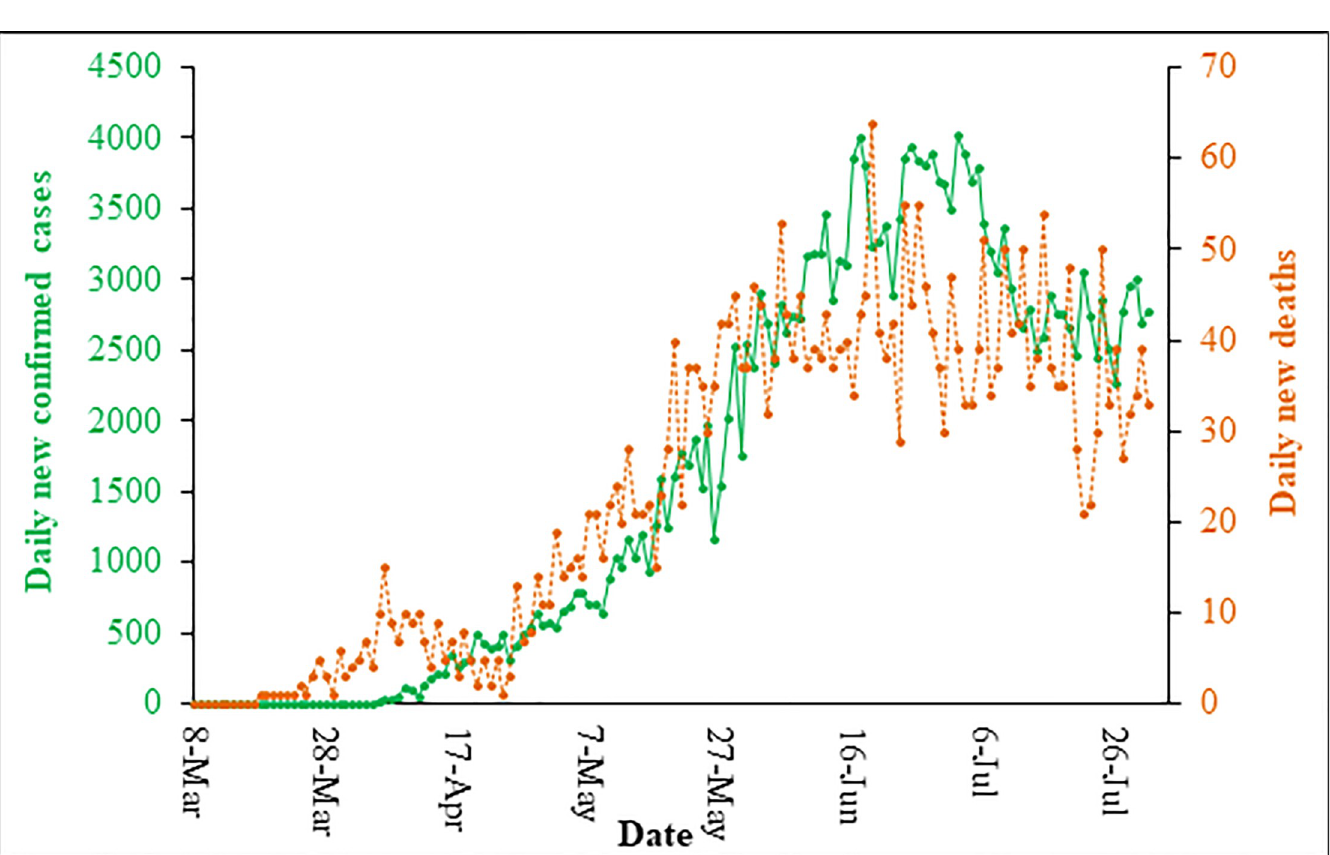
Fig 1. Nationwide confirmed cases and deaths in Bangladesh